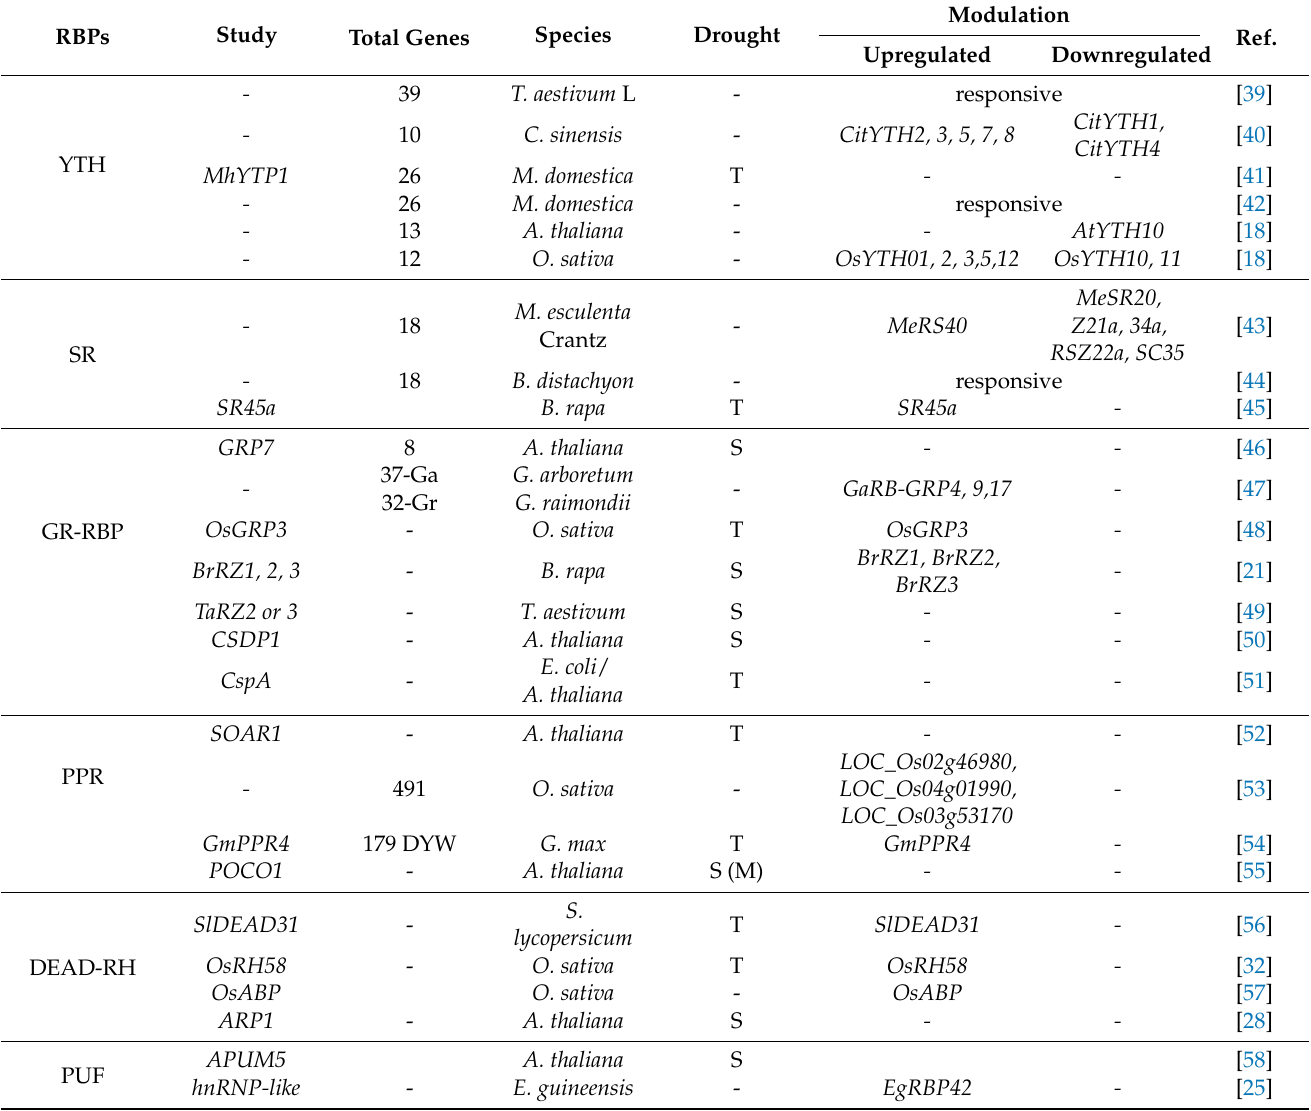
Table 1. Plant RNA binding proteins implicated in drought stress responses.